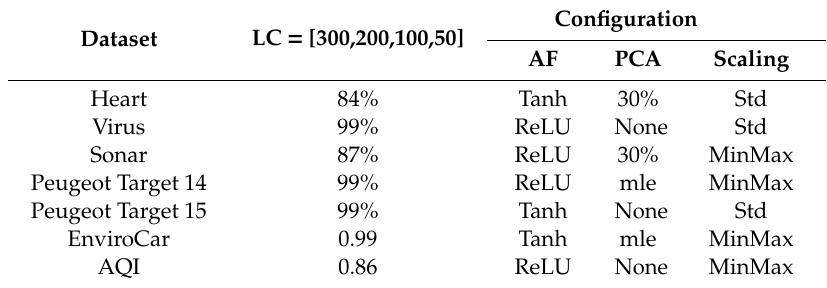
Table 29. Layer Configuration (LC) = [300,200,100,50]